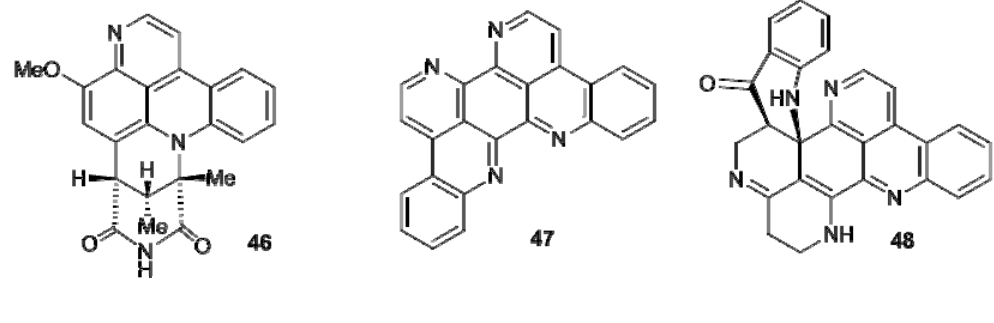
Figure 3. Structures of segoline A ( 46 ), eilatin ( 47 ), and eudistone A ( 48